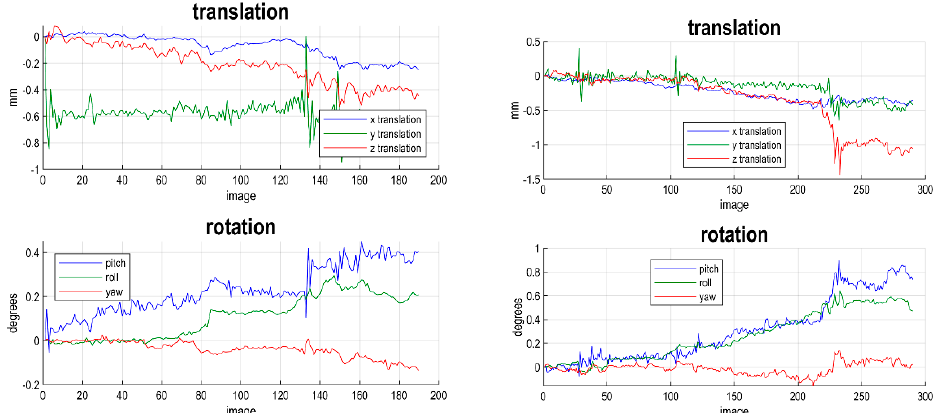
Figure 1. An example of one subject with a magnitude of movement in translation x , y and z and pitch, roll and yaw. This subject only shows a movement below 1 mm.